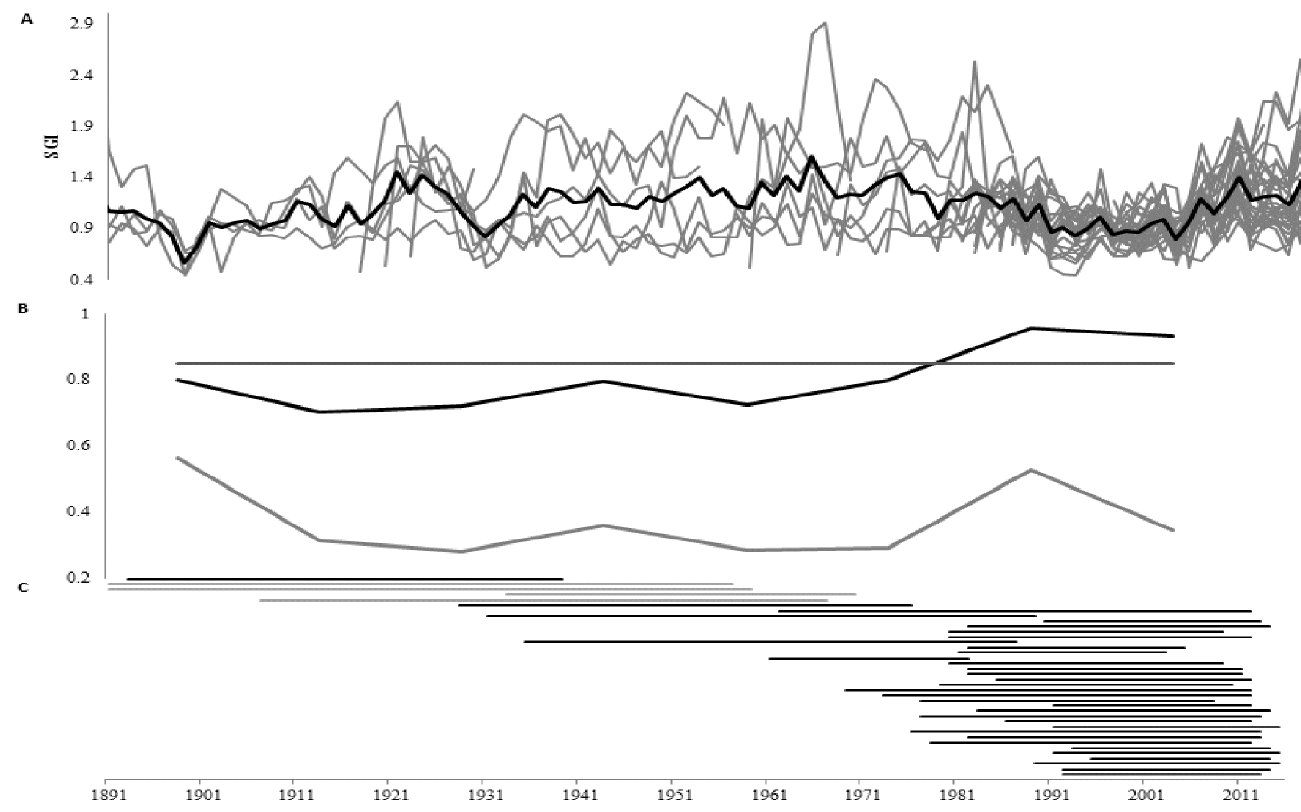
Fig 3. A) Detrended increment measurements (grey lines) and ARSTAN created standardized (STD) chronology (black line); B) EPS and RBar values calculatedin a 20 year windowwith a seven year overlap. The horizontalline shows the 0.85 threshold (see text); C) The positionof each of the shells in the chronology. The grey lines indicate shells sent for